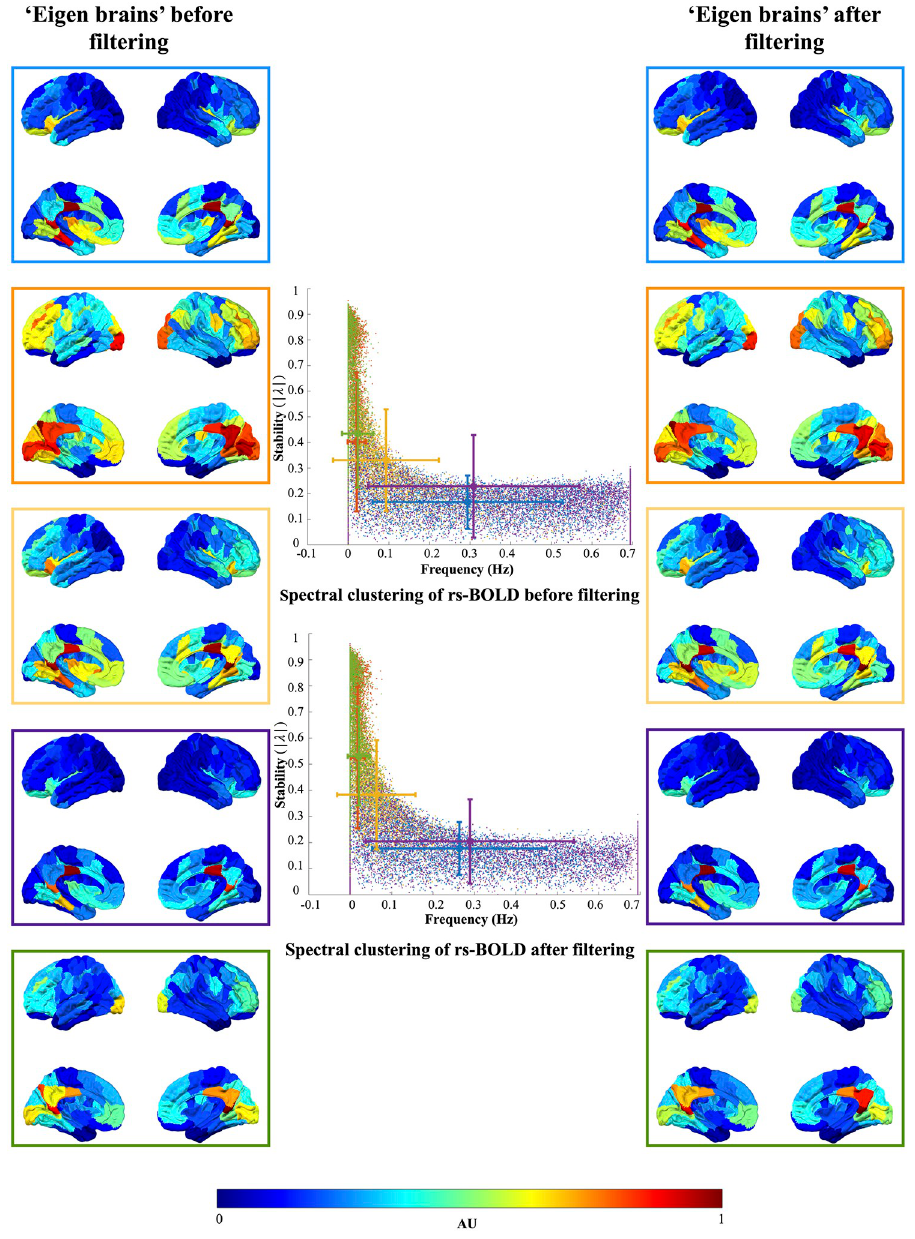
Fig 9. Clustering of eigenvectors and eigenvalues obtained from resting-state BOLD signal and ARFIMA (1, d , 0) (model-based) filtered resting-state BOLD signals. All eigenvectors from all subjects were normalised and clustered into 5 clusters using k -means clustering. The clusters were color-coded across all subjects and all runs (98 subjects × 4 runs × 100 eigenmodes = 39,200 eigenvalues). The color codes blue, orange, yellow, purple and green correspond to cluster 1, 2, 3, 4 and 5, respectively. The plot in the centre shows the distribution of eigenvalues based on their frequency (the argument of eigenvalue) and stability (the absolute magnitude of eigenvalue) of resting-state and ARFIMA filtered BOLD signals. Error bars represent the mean and standard deviation of the average eigenvalue of each cluster. The eigenvalues are color coded based on the five identified clusters. The brain overlays in the left and right panel represent the spatial distribution of the eigenvector corresponding to the eigenvalue (same color coded) of resting-state BOLD signals before and after filtering, respectively. The cluster centroid (plotted on the brain overlays) were normalised by subtracting each centroid by its minimum element. Colorbar represents the normalised values of cluster centroid for each cluster (left and right panel).